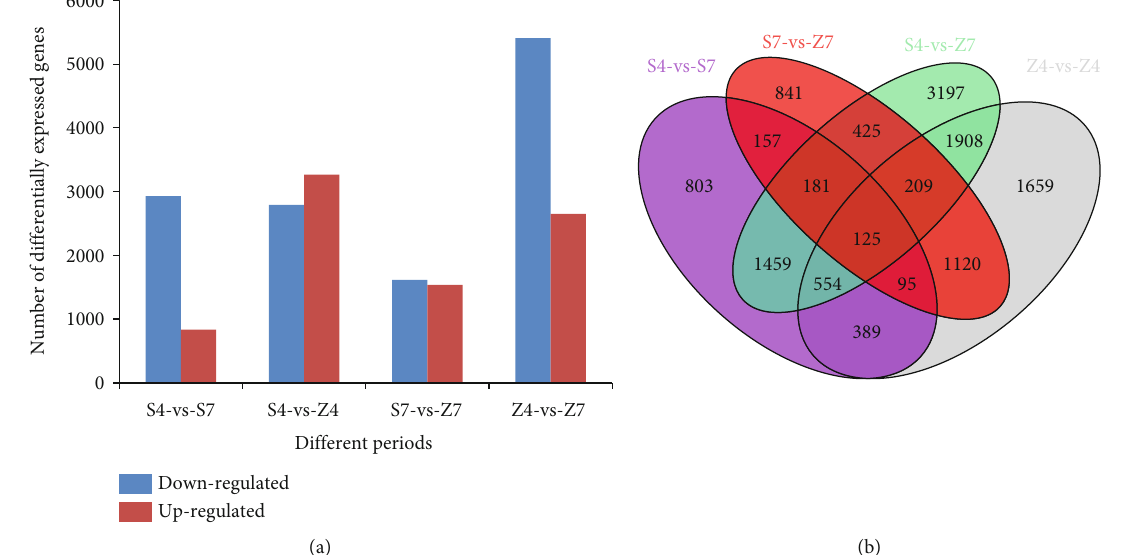
Figure 3: Functional annotation and classi fi cation of di ff erentially expressed genes between R4 and R7 pod stages of Shanhua15 and Zhonghua12. (a) Number of di ff erentially expressed genes. (b) Venn diagram. S4, Shanhua15 R4 pod period; Z4, Zhonghua12 R4 pod period; S7, Shanhua15 R7 pod period; Z7, Zhonghua12 R7 pod